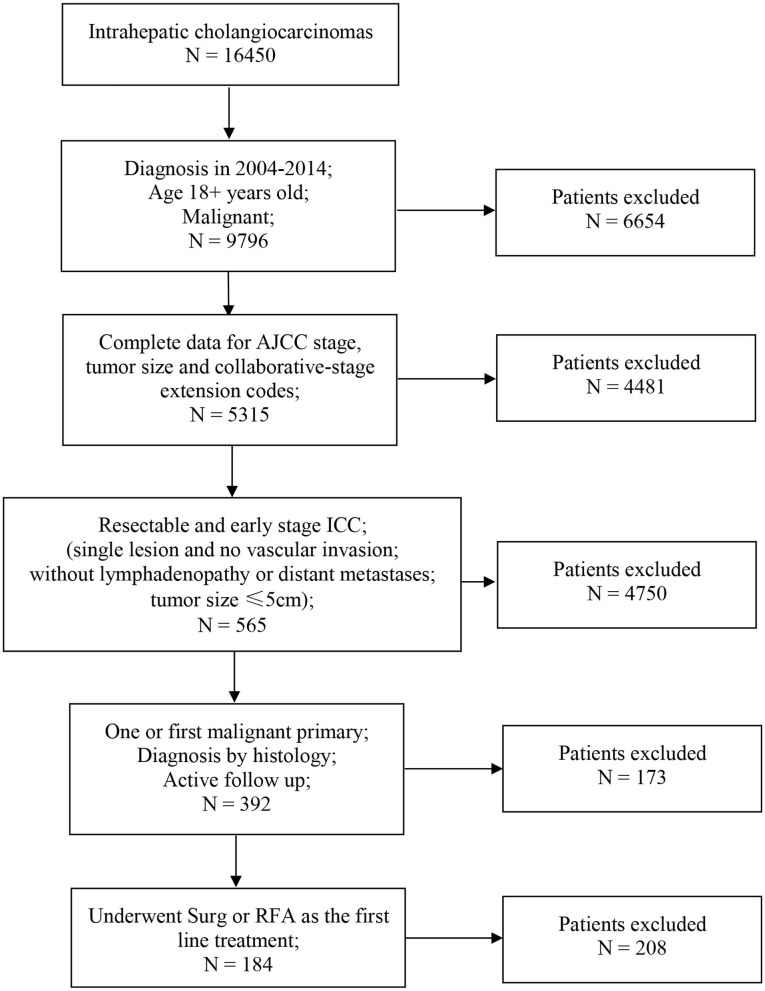
Flowchart of patients selection. AJCC, American Joint Committee on Cancer; ICC, intrahepatic cholangiocarcinoma; Surg, surgical resection; RFA, radiofrequency ablation.